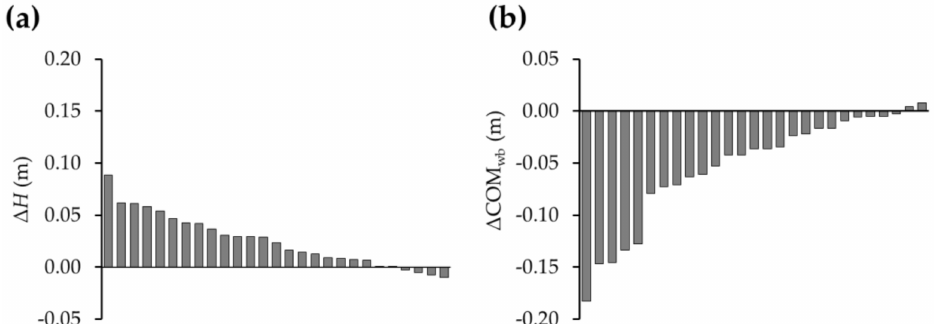
Figure 2. ( a ) The di ff erence in jump height ( ∆ H ) and ( b ) the di ff erence in whole-body COM height ( ∆ COM wb ) for each participant. Each bar represents a participant. They are arranged in descending ( a ) and ascending ( b ) order.